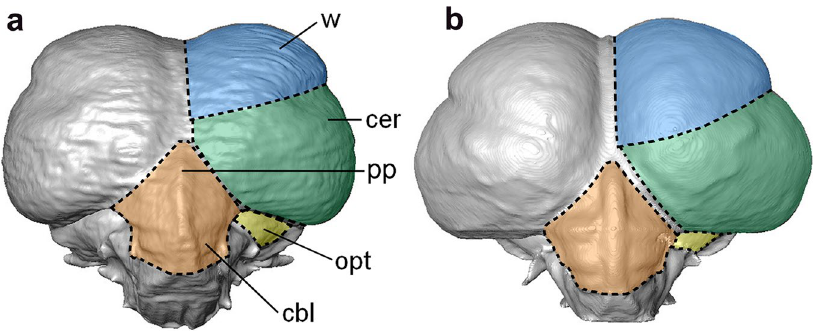
Figure 5. Cranial digital endocasts of O. murivorus ( a ) and O. sunia ( b ) in caudal view. cbl, cerebellum; cer, cerebral hemisphere; opt, optic lobe; pp, pineal peak; w, wulst. The protuberance of the pineal peak could a priori have been a proxy of diurnal or nocturnal behavior 24,25 , but this detail has proven hardly assessable on the fossil, and moreover, it shows no consistent relation to the more diurnal species examined here. Not to scale.